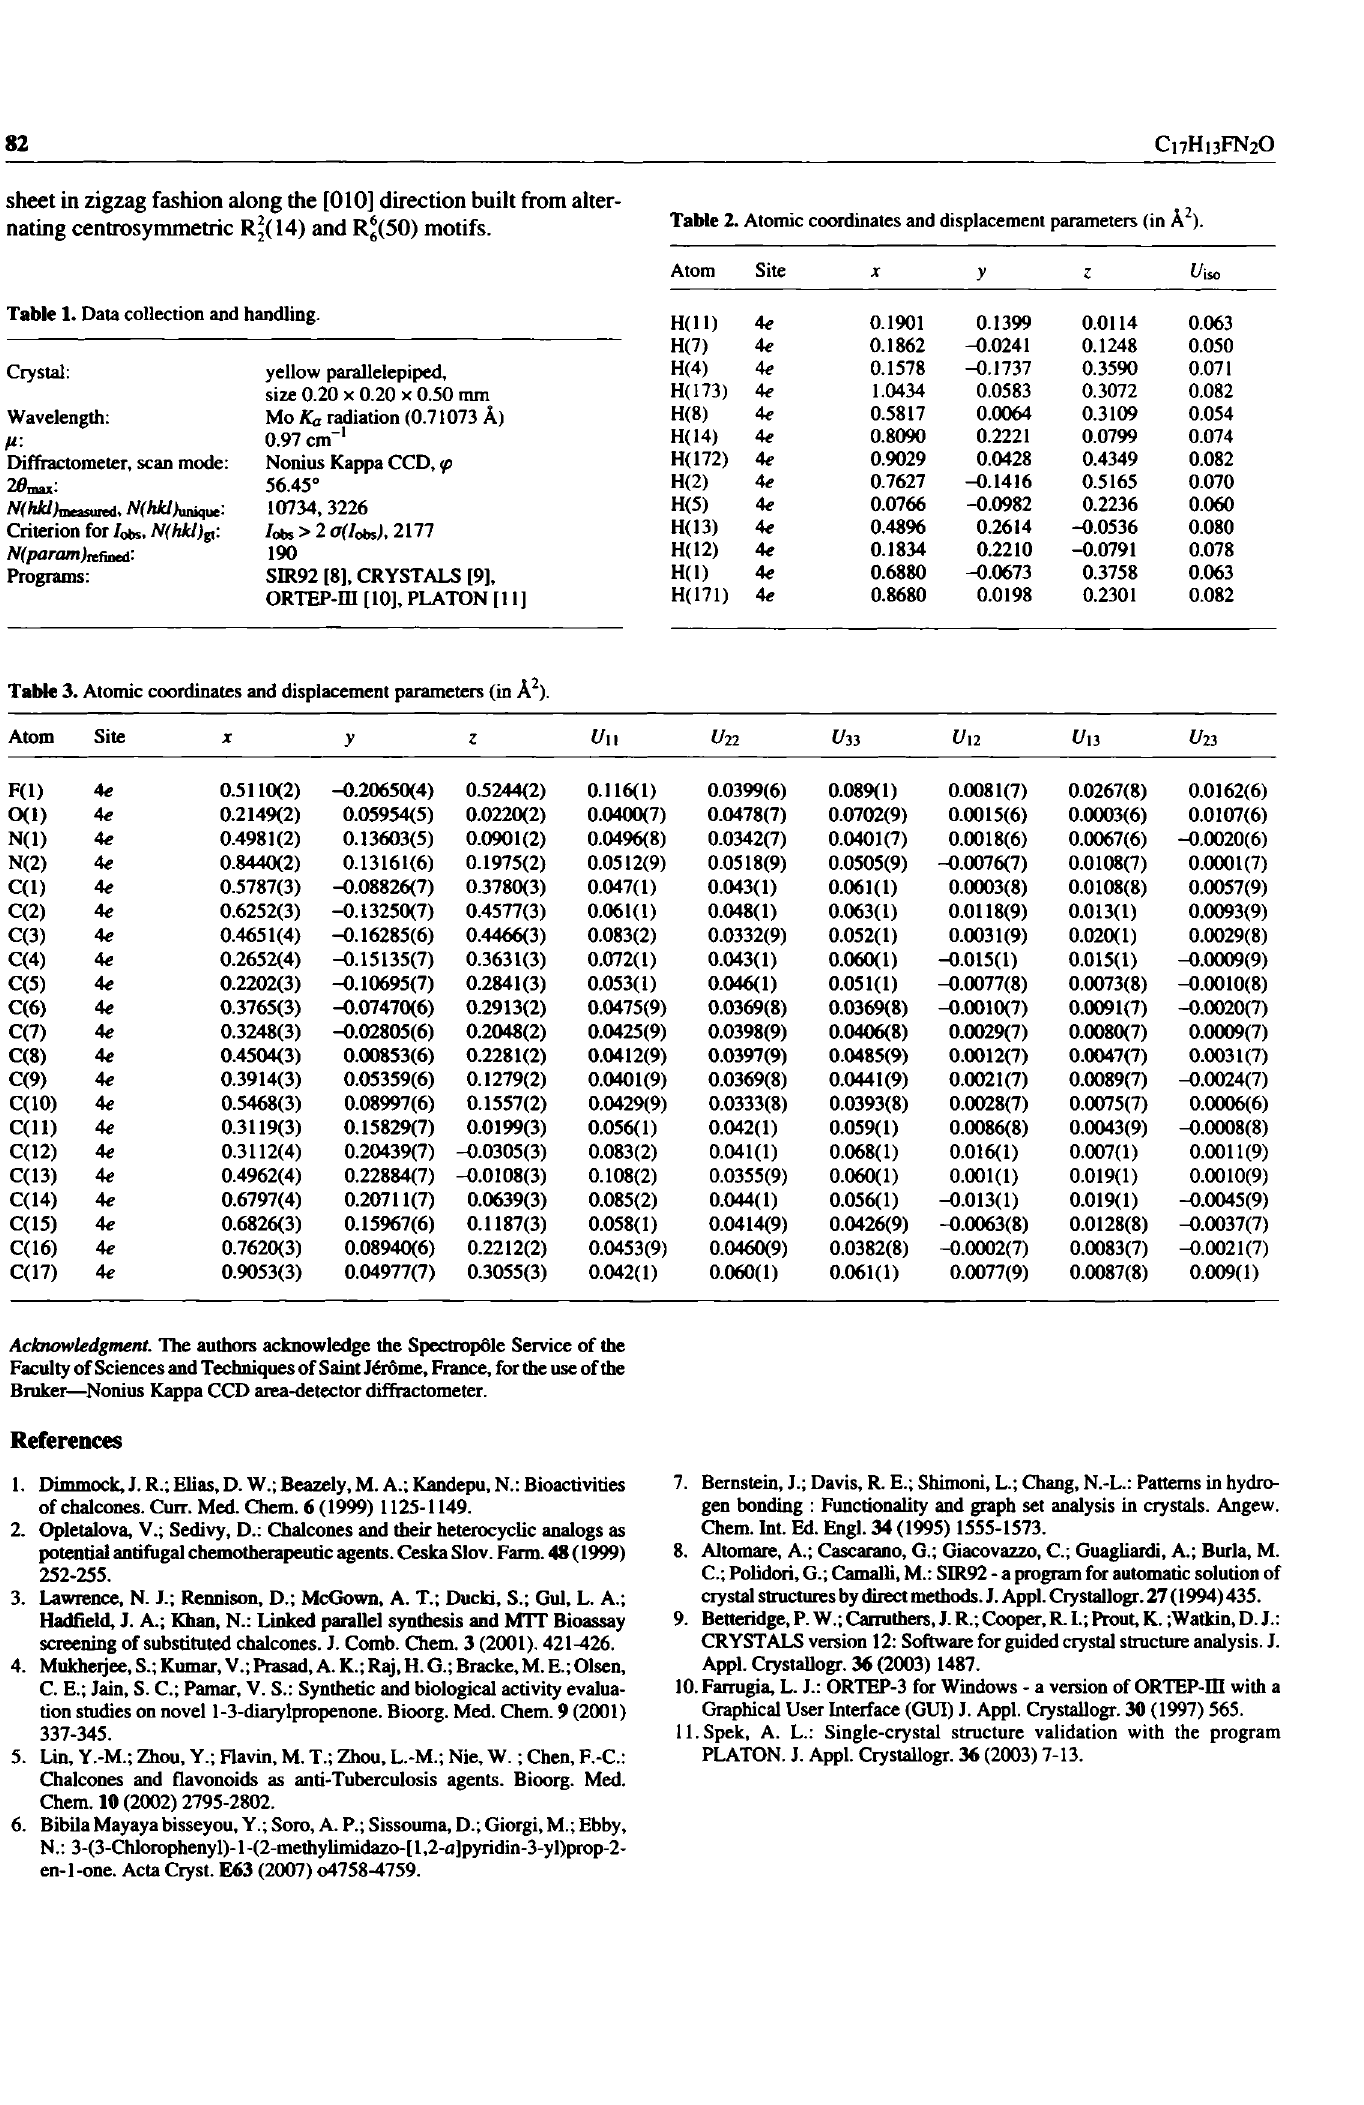
Table 1. Data collection and handling.